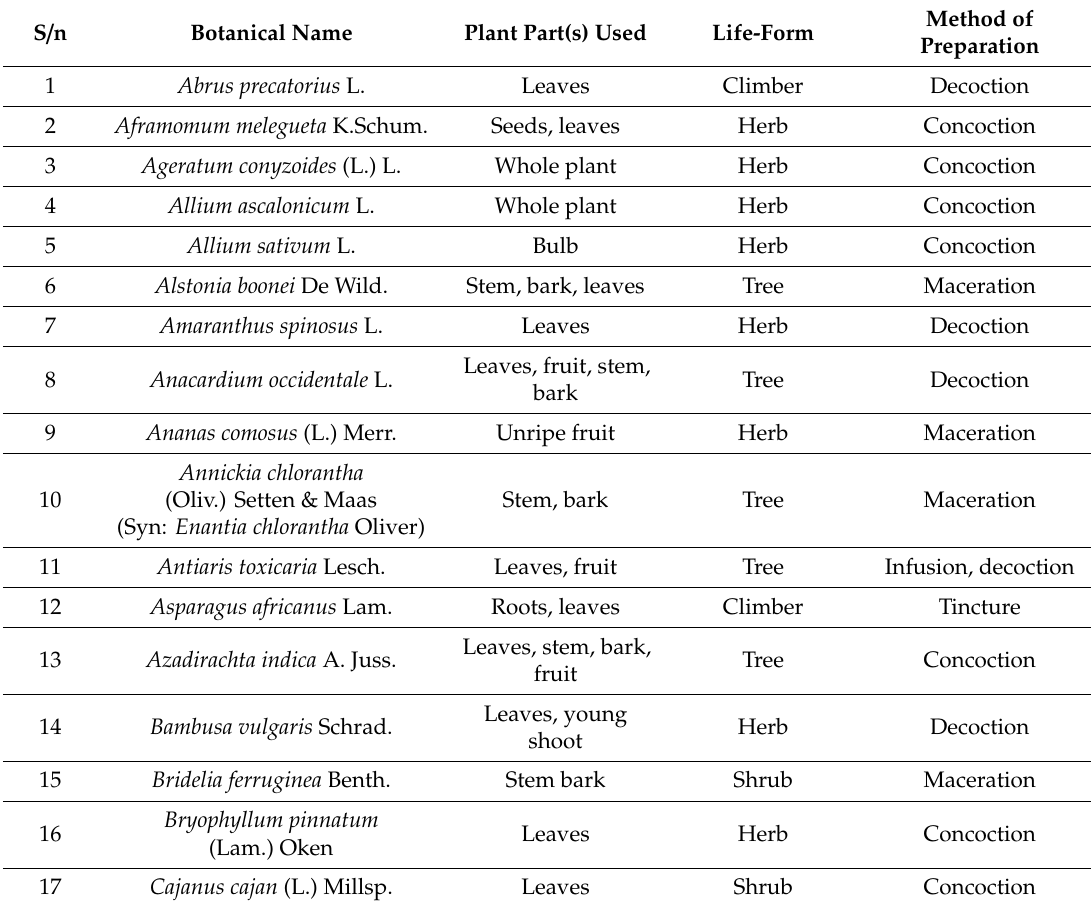
Table A1. Inventory of plant species used for treating cough associated with respiratory diseases in Ede South Local Government Area of Osun State,